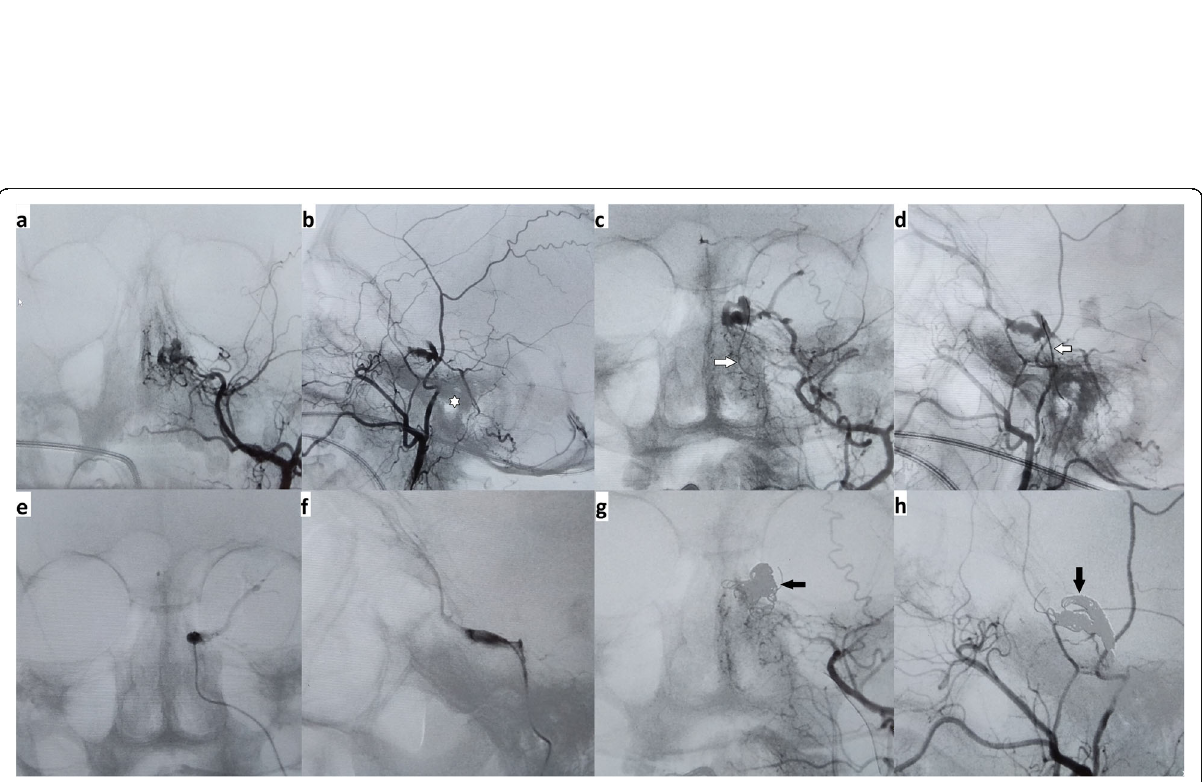
Fig. 6 Left ECA DSA in AP ( a ) and lateral ( b ) projections show type C indirect CCF with occluded left IPS (asterisk in b ). DSA in AP ( c ) and lateral ( d ) projections show successfully recanalized IPS with the microcatheter (white arrow) in place. DSA in AP ( e ) and lateral ( f ) projections show tip of the microcatheter lying within the cavernous sinus. Post coiling DSA in AP ( g ) and lateral ( h ) projections show coil mass (black arrow) in the cavernous sinus and complete embolization of the fistula